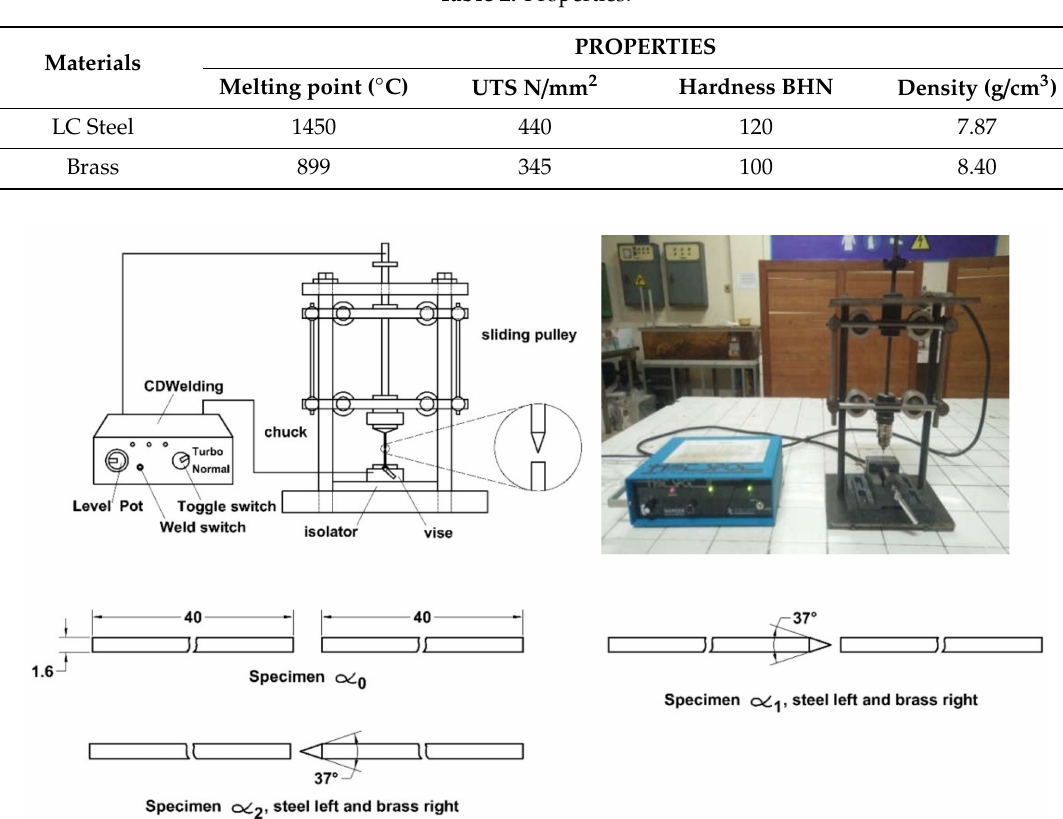
Figure 1. Capacitive discharge welding (CDW)